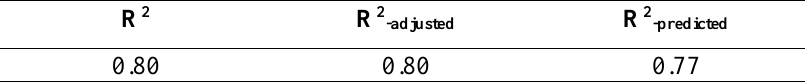
Table 3. Summary of the transformed-data regression